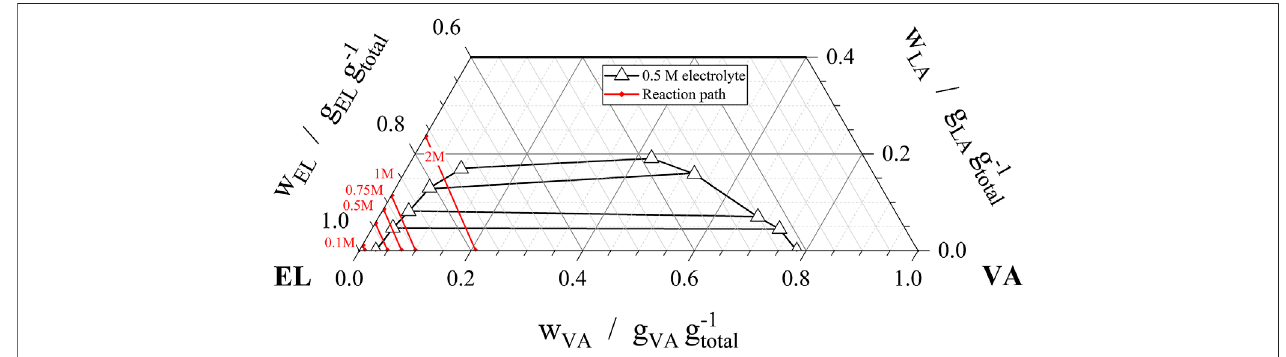
FIGURE 4 | Operating range of the electrochemical conversion process derived from liquid – liquid equilibrium measurements and range of initial Levulinic acid (LA) concentration where a second organic product phase is formed upon reaction.